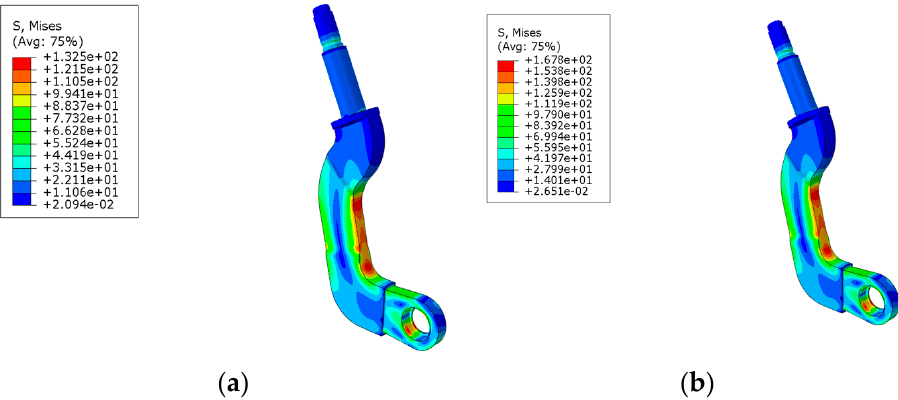
Figure 10. Stress distribution in the boom under two operating conditions. ( a ) Stress nephogram of the boom at rated working conditions; ( b ) Stress nephogram of the boom at start-up.